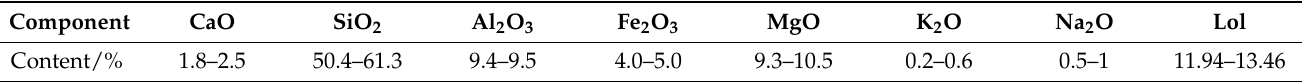
Table 1. Composition of